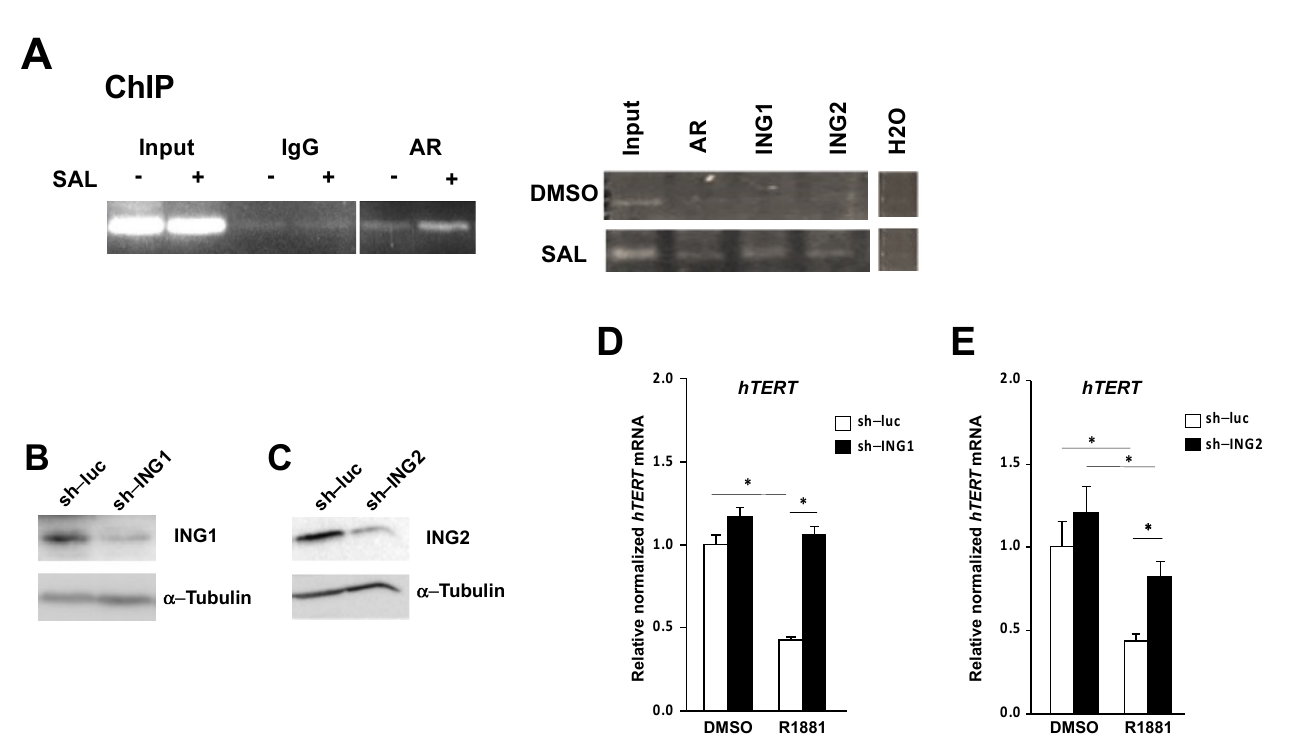
Figure 6. The tumor suppressors ING1 and ING2 mediate the androgen-regulated transrepression of hTERT. ( A ) ChIP experiments using antibodies against AR, ING1, and ING2 for LNCaP cells treated with either DMSO as the solvent control or SAL. Immunoprecipitates were analyzed by nested PCR for the proximal hTERT region. ( B , C ) Western blot of ING1 ( B ) or ING2 ( C ) of LNCaP cell extracts using shRNA knockdown for ING1 (sh-ING1), ING2 (sh-ING2), or the control vector (sh-luc). α -Tubulin detection served as the loading control. ( D , E ) qRT-PCR of endogenous hTERT expression with and without ING1 knockdown ( D ) or ING2 ( E ) knockdown in the presence of androgen or DMSO as the solvent control. * p ≤ 0.05.